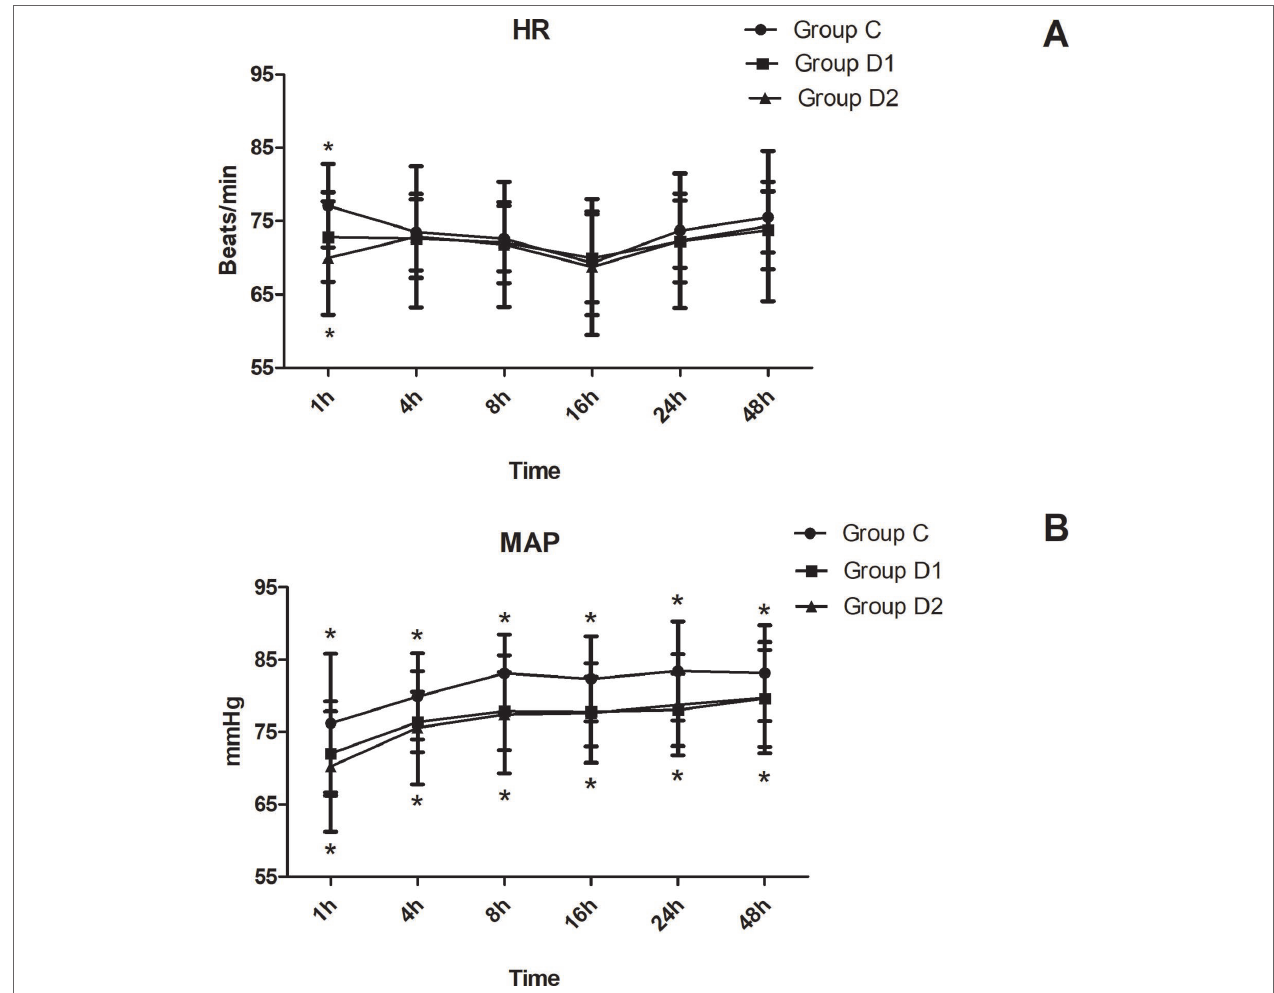
FIGURE 3 | Hemodynamics changes during the first 48 h after surgery. (A) Comparison of HR in the three groups at different time-points. (B) Comparison of MAP in the three groups at different time-points. * P < 0.05 vs. Group C.